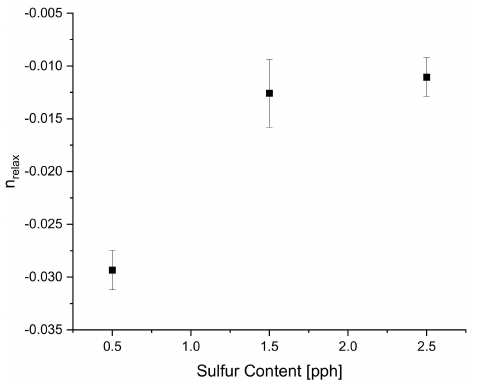
Figure 31. The curved response of sulfur content on n relax , further confirming the results in the Pareto